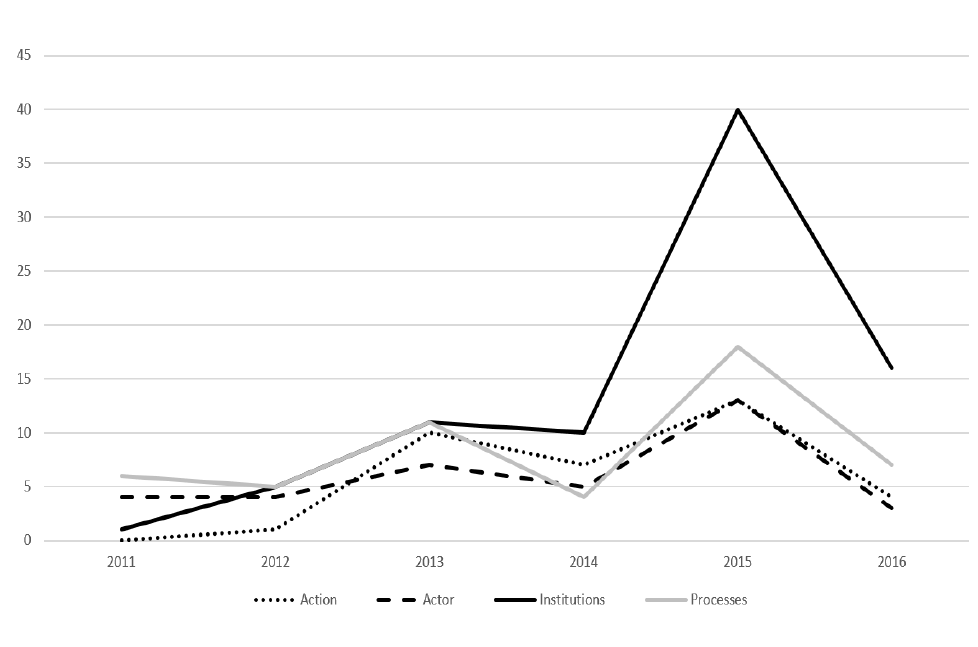
Figure 3: Russian references to the four most common objects